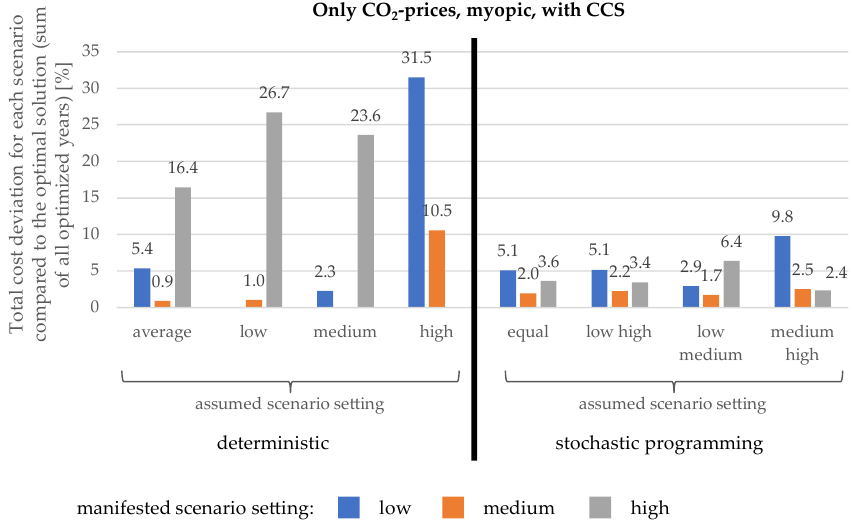
Figure 7. Total cost deviation per scenario compared to the optimal solution for uncertain CO 2 prices (myopic, with CCS).